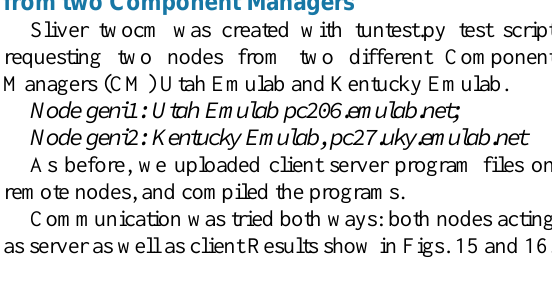
Fig. 14: Error in communication when ProtoGENI